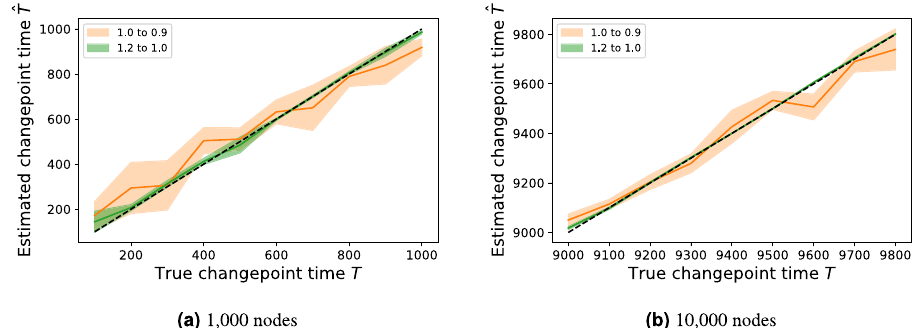
Figure 5. Maximum likelihood estimators for time at which degree power exponent changes value, with mean and standard deviation error areas calculated over 10 experiments. In both ( a ) and ( b ), a network is generated with each new node joining connecting to 3 existing nodes, node i chosen with probability p i as in Eq. (8). The shaded region represents a 95% confidence interval over the 10 experiments.